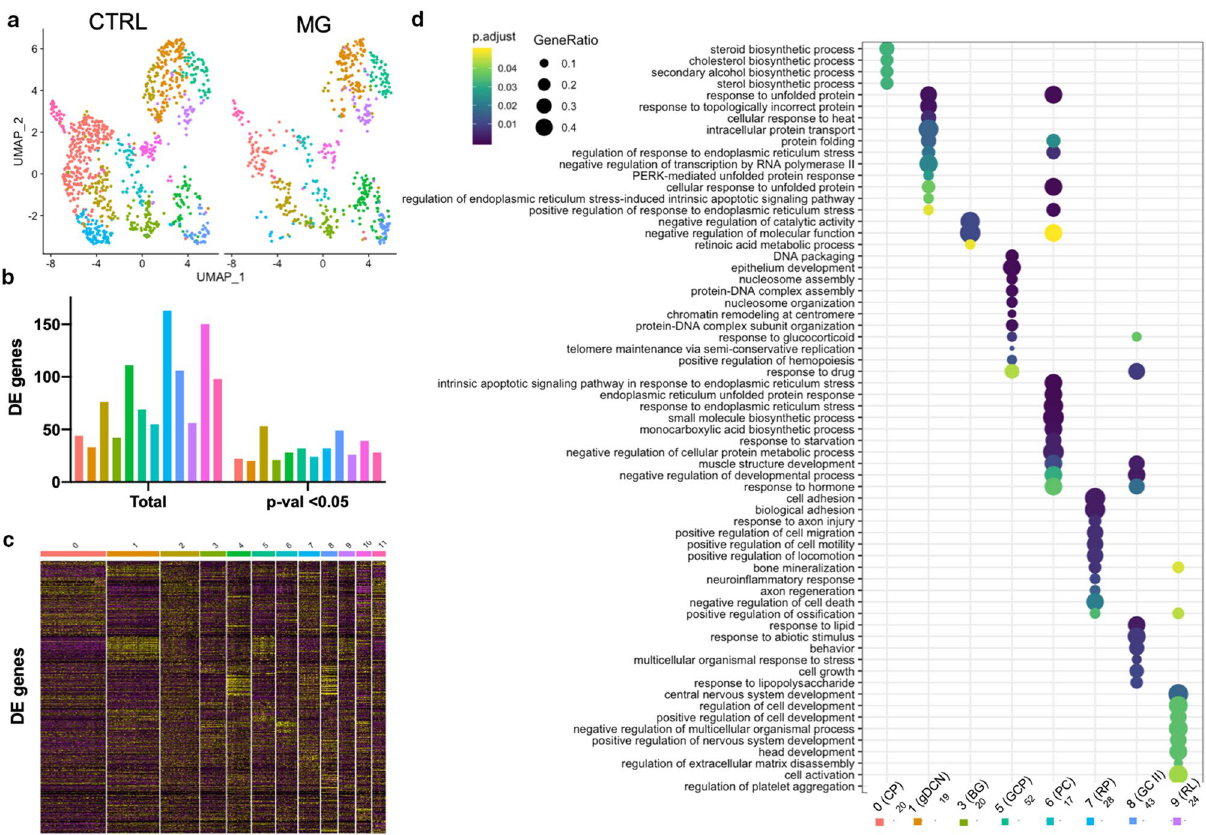
Figure 4. Cerebellar populations show distinct responses to Matrigel encapsulation. ( a ) UMAP projections outlining equivalent populations from control (CTRL) and Matrigel (MG)-embedded cell groups for differential-expression testing. ( b ) Graph depicting numbers of total (left) and significantly changing genes (right) per cell population. P-value < 0.05 accepted as significant. ( c ) Heatmap depicting all differentially- regulated genes between untreated and MG-embedded organoids. Heatmap made with Seurat (v3.2.1) ( d ) Dot plots showing the top differentially expressed GO pathways per cell population. The number of genes considered for each population is listed on the x-axis below cell